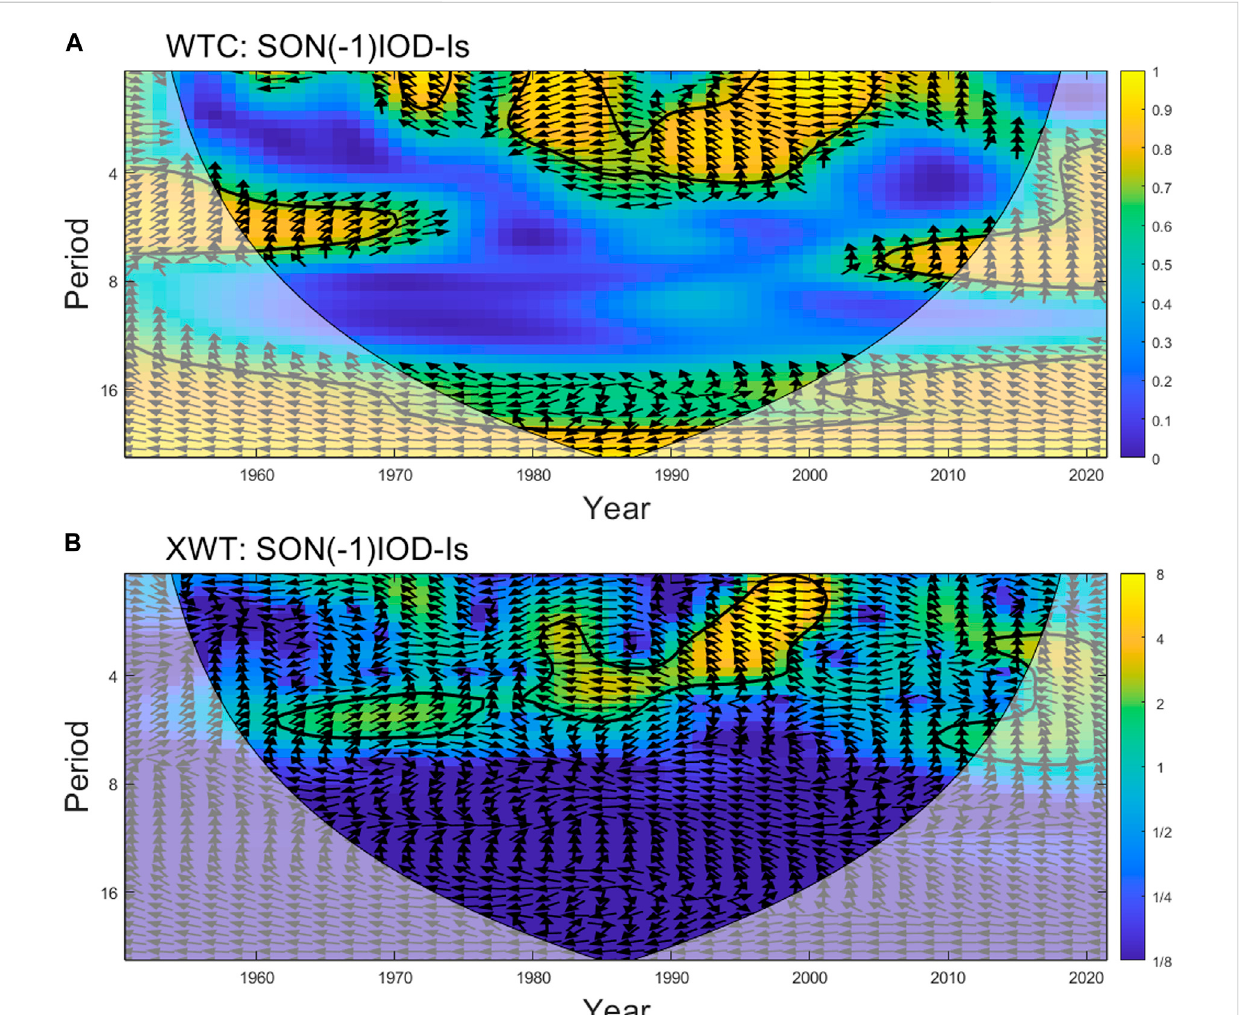
FIGURE 3 (A) Wavelet coherence spectrum (B) cross-wavelet spectrum of the previous autumn IOD and SCSSM index; In the fi gure, the arrow indicates the relativebit difference, therightarrow indicates that thetwochange bitsare consistent, and theleftarrowindicatesthat thechangebitsareopposite(The others are the same as Figure